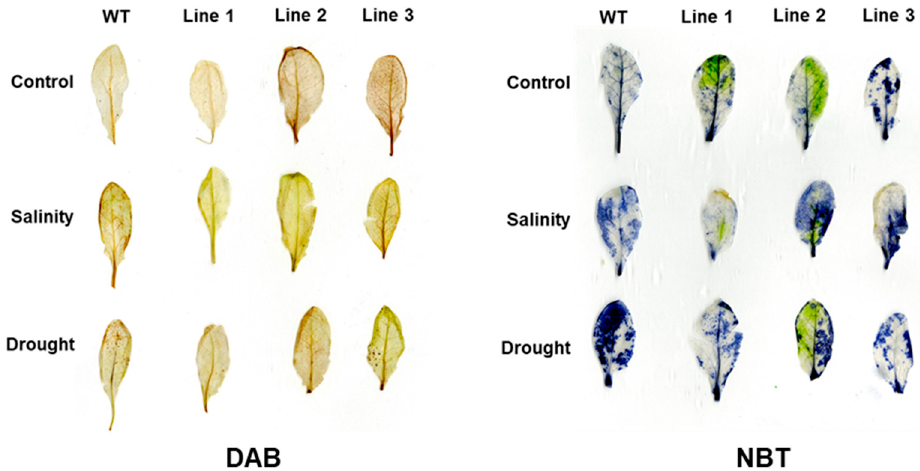
Figure 9. The 3,3-diaminobenzidine (DAB) and nitro blue tetrazolium (NBT) histochemical staining of WT and transgenic Arabidopsis plant leaves under salinity and drought stress conditions.